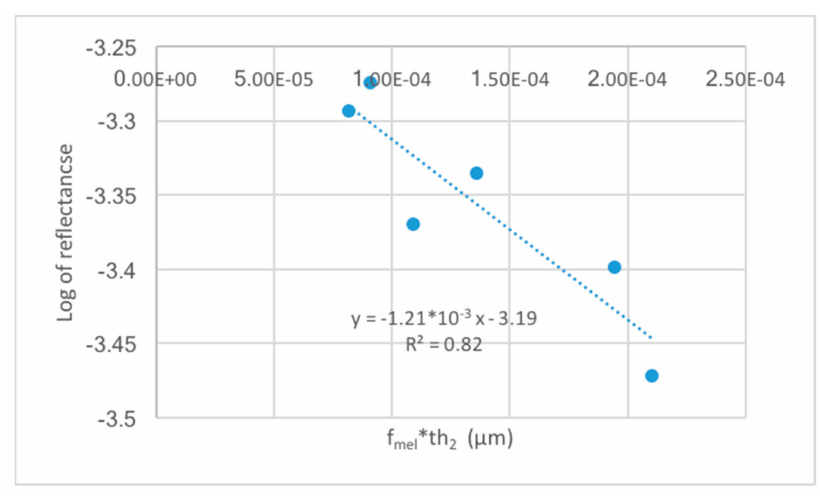
Figure 9. Log of reflectance of SDS 0.22 mm on 500 nm vs. f mel × th 2